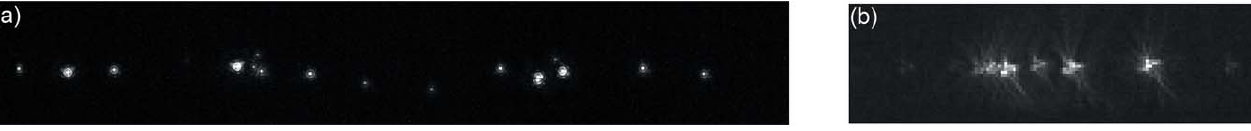
Figure 10 An aerosol particle beam with particles of size of a few tens of nanometres visualized by Rayleigh scattering imaging using the ( a ) inline microscope with 10 (cid:3) objective and ( b ) side microscope with 2 (cid:3)